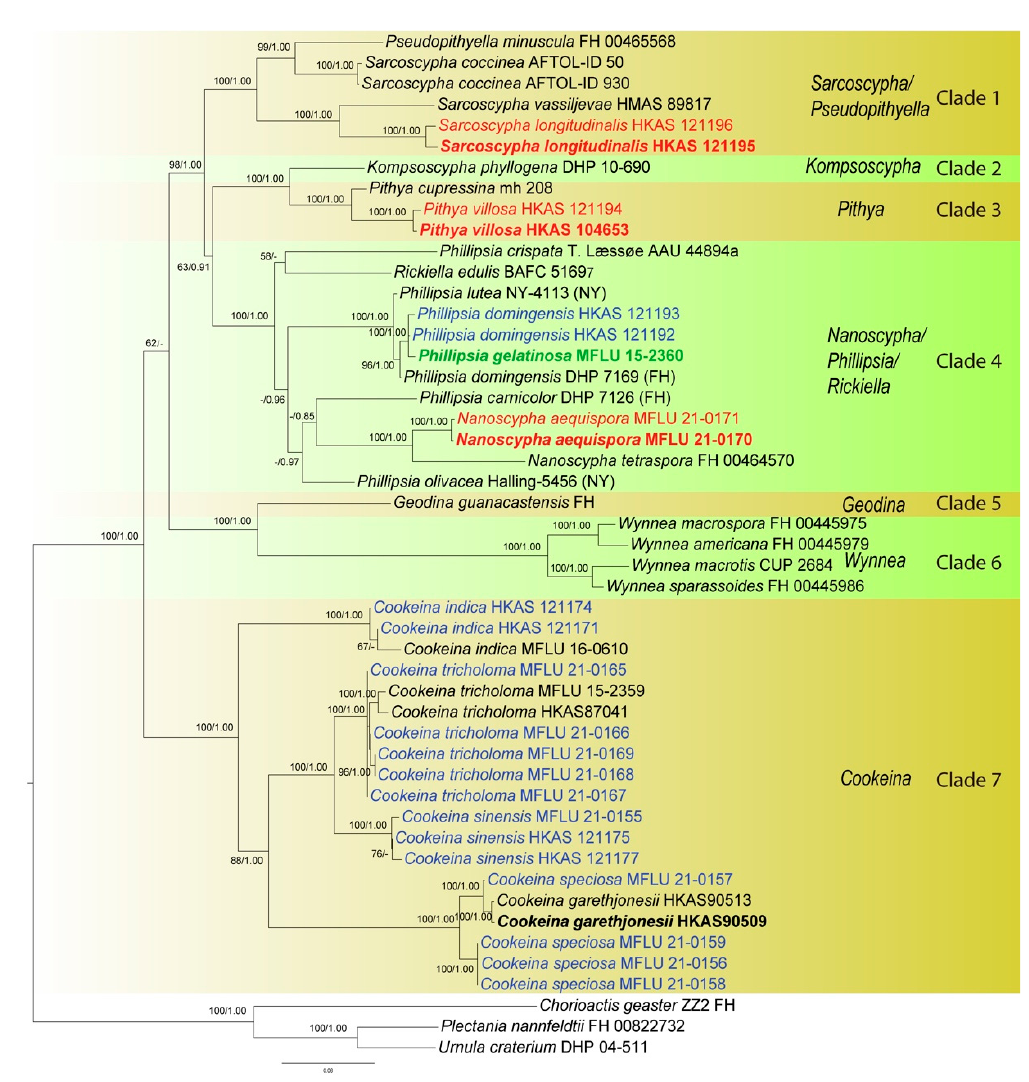
Figure 2. Phylogenetic tree of combined ITS, LSU, SSU, rpb2 , and tef-1 α sequence data inferred from 49 taxa and 4366 sites under the GTR + G + I model of nucleotide substitution. Numerical values at the nodes indicate maximum likelihood bootstrap support (BS) and posterior probabilities (PP). Values of BS greater than 50% and PP over 0.80 are indicated above or below the nodes in this order. Names in red indicate newly-described species and names in blue stand for newly-sequenced collections. Names in green indicate correction to Phillipsia domingensis . Tree is artificially rooted to Chorioactis geaster (ZZ2 FH), Plectania nannfeldtii (FH 00822732) and Urnula criterium (DHP 04 ‐ 511).